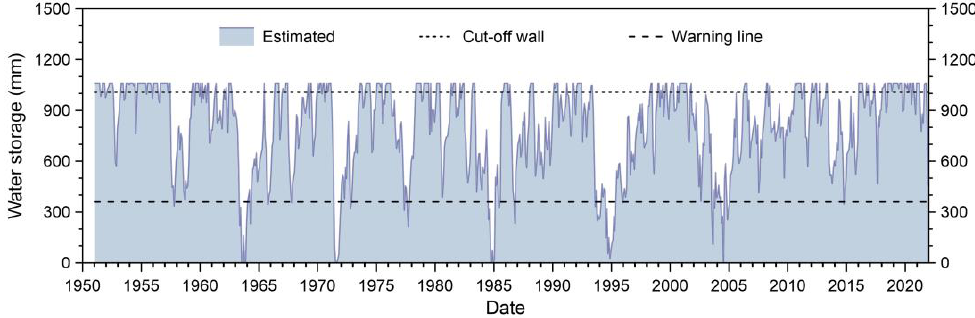
Figure 10. Estimated long-term changes in water storage under the current irrigation area and practice using 1951‒2021 climate data.